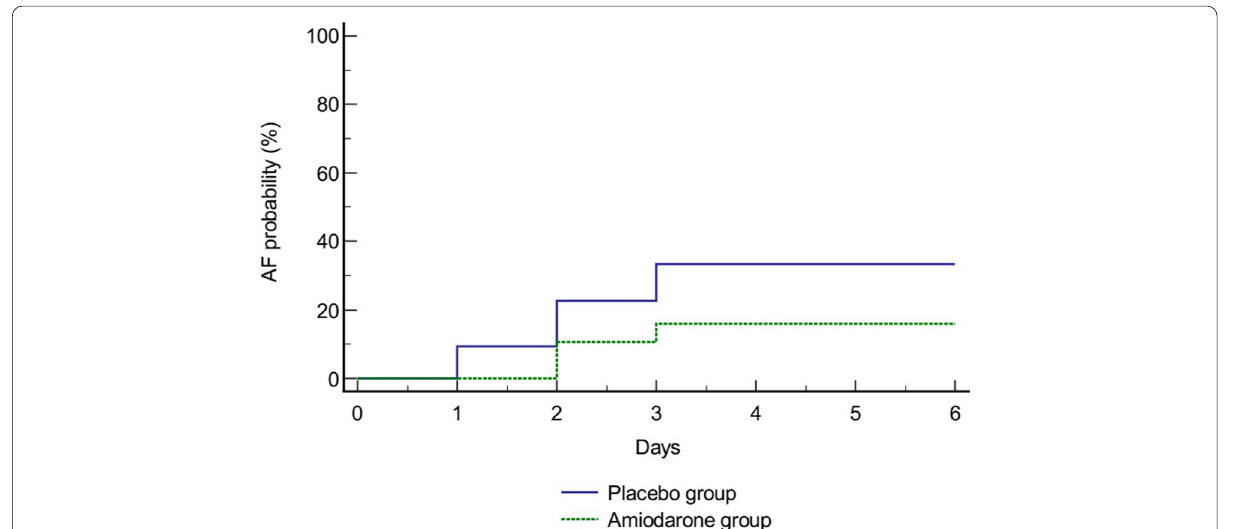
Fig. 2 Kaplan-Meier curve of cumulative incidence of atrial